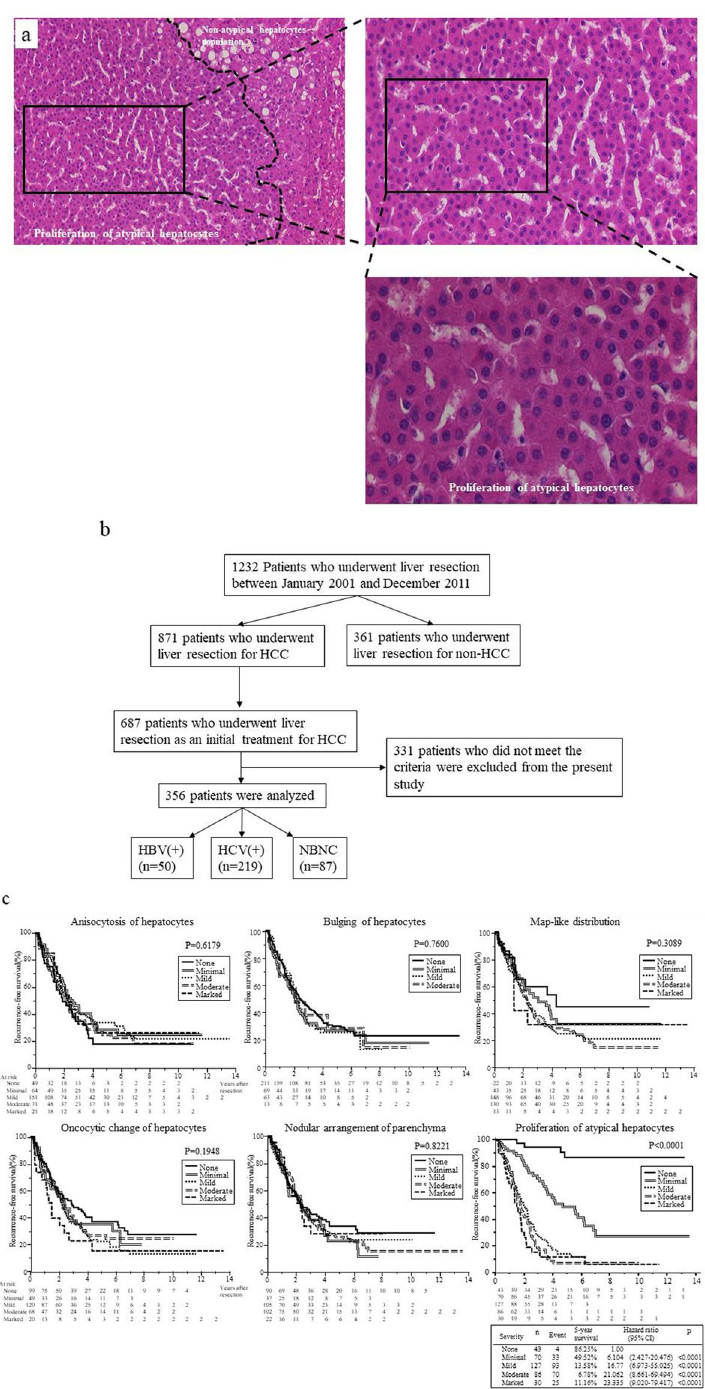
Figure 1. Images of proliferation of atypical hepatocytes. ( a ) Low magnification image of atypical hepatocyte cluster (upper left image; hematoxylin and eosin (HE) staining, × 40). Moderate magnification image of the insert in the upper left panel. The area surrounded by the dashed line encloses an atypical hepatocyte cluster (upper right image; HE, × 200). High magnification image of upper right pane show the atypical hepatocyte cluster (bottom right image; HE, × 400). ( b ) The patients enrolled in Cohort 1 in this study. Based on the inclusion criteria, 331 of 687 patients were excluded. ( c ) Comparison of the cumulative incidence of recurrence- free survival (RFS) rates according to the different grade of irregular regeneration of hepatocytes of the six hepatocyte groups in noncancerous HE-staining sections. Anisocytosis of hepatocytes (p = 0.6179); bulging of hepatocytes (p = 0.75); map-like distribution (p = 0.3089); oncocytic change of hepatocytes (p = 0.1948); nodular arrangement of parenchyma (p = 0.8221); proliferation of atypical hepatocytes (p < 0.0001). Data were analyzed using the Kaplan–Meier method, and differences among groups were analyzed using the logrank test. HBV (+); hepatitis B virus surface antigen-positive, HCV; hepatitis C virus antibody-positive, NBNC, patients without HBsAg or anti-HCV antibody, RT-qPCR, real-time reverse transcription-quantitative